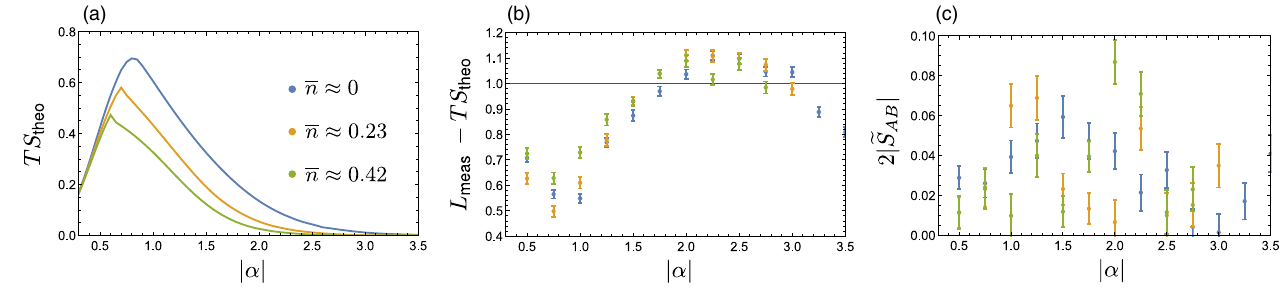
˜ S ˜ S ˜ S AB j þ j BC j þ j AC jÞ